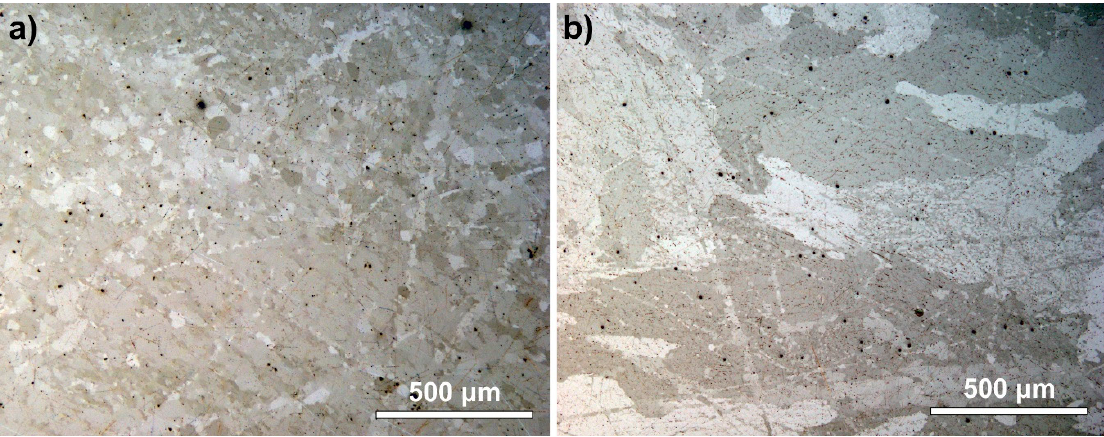
Figure 3. Optical micrographs of the microstructure of the samples: ( a ) reference; ( b ) annealed at 180 °C for 72 h.